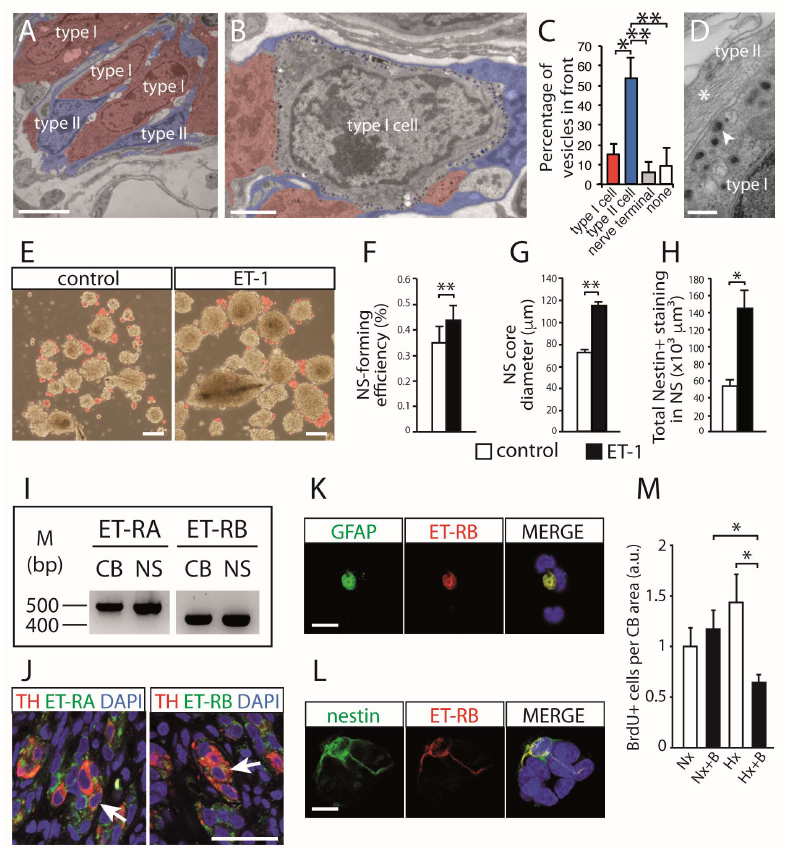
Figure 3. Carotid body multipotent stem cells and chemo-proliferative synapse. ( A ) Pseudocolored electron micrograph of a CB ultrathin section of a normoxic mice showing the close association of type II progenitor cells with glomus (type I) neuronal cells. Scale bar, 5 µ m. ( B ) Pseudocolored electron micrograph illustrating the cellular elements surrounding a typical glomus cell within the CB parenchyma. Type II cells, and the type I vesicles facing them, appear in blue; type I cells, and the vesicles facing them, appear in red. Scale bar, 2 µ m. ( C ) Quantification of the percentage of dense-core vesicles facing each of the di ff erent cellular elements surrounding a typical type I cell. ( D ) Electron micrograph of a CB slice, showing details of the contact area between type II and type I cells. Example of exocytotic vesicle apposed near the membrane is indicated with arrowhead. A bundle of intermediate filaments, characteristic of type II cells, is indicated by an asterisk. Scale bar, 2 µ m. ( E ) Bright-field images